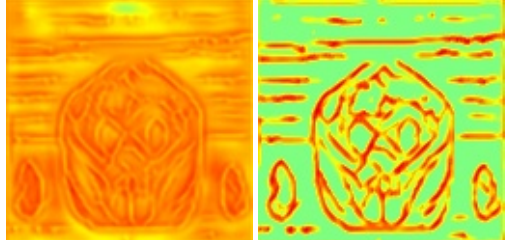
Figure 3. Two modes of feature fusion: ( a ) element-wise multiplication and Sigmoid activation function ( b ) channel-wise concatenate.